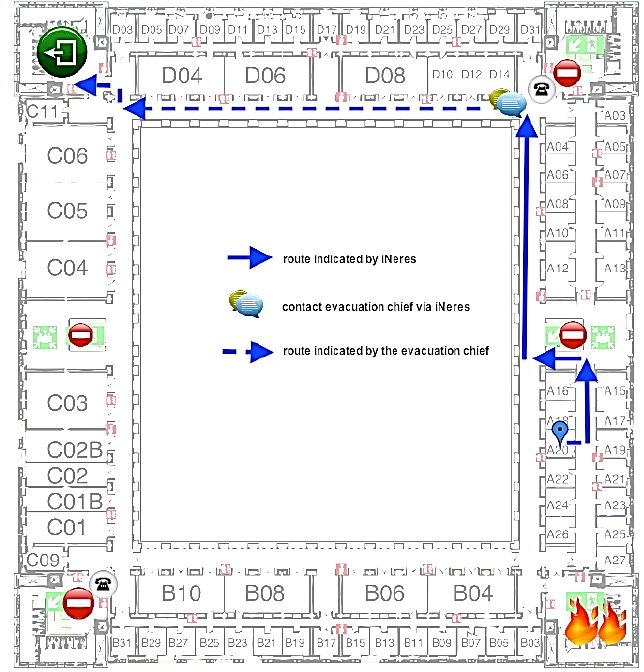
Figure 9. Map with the evacuation route provided by iNeres starting from the user’s location and the point where user has contacted with the Command